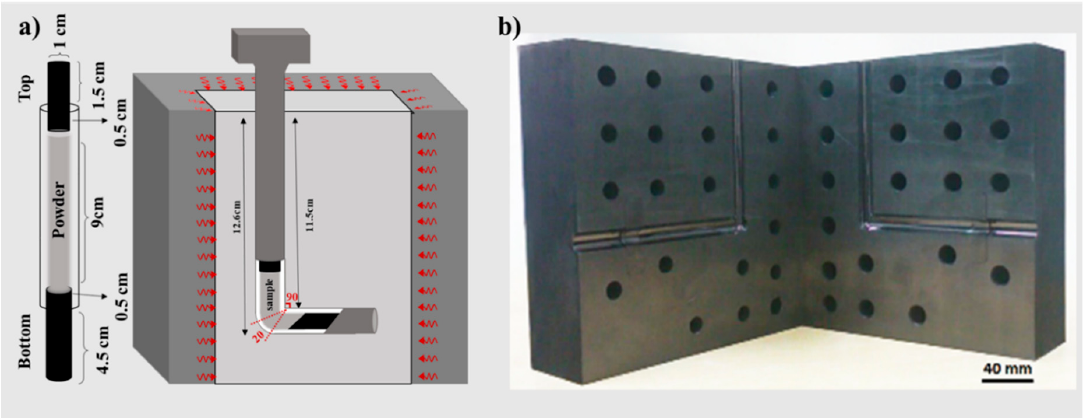
Figure 2. ( a ) Schematic of the consolidation process and ( b ) the equal-channel angular pressing (ECAP) die used in the current research.